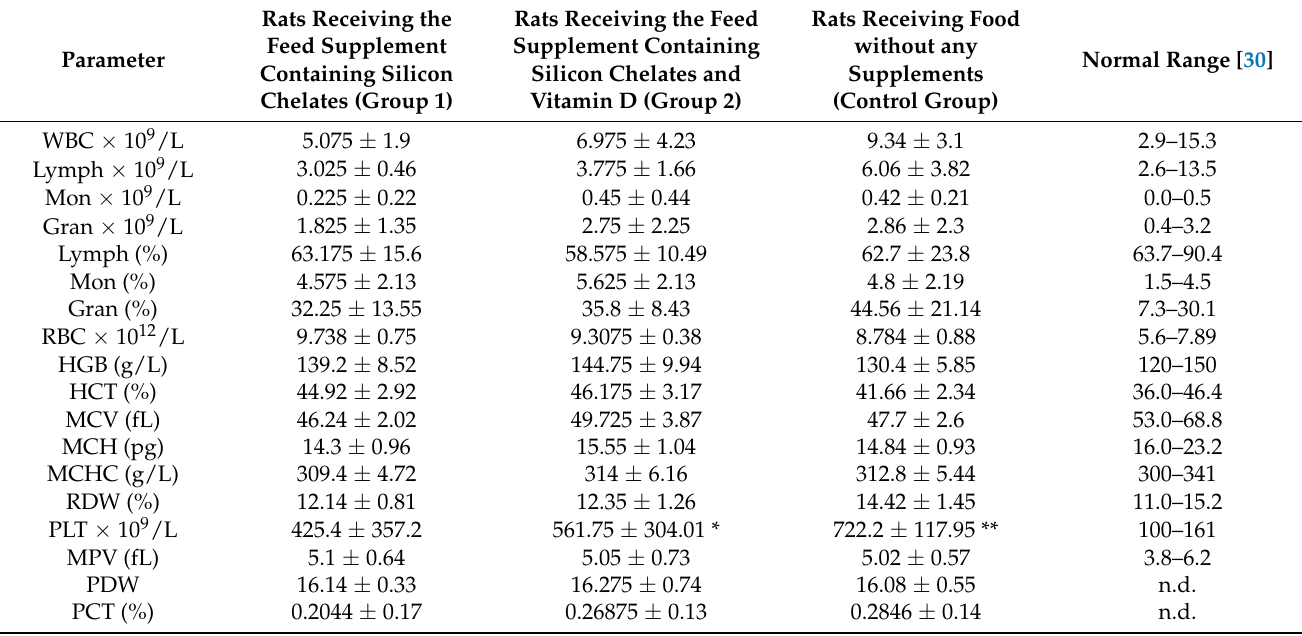
Table 3. The blood morphology parameters of rats receiving feed supplements containing chelated silicon and vitamin D after the experimentally induced mechanical damage to the femoral bone.